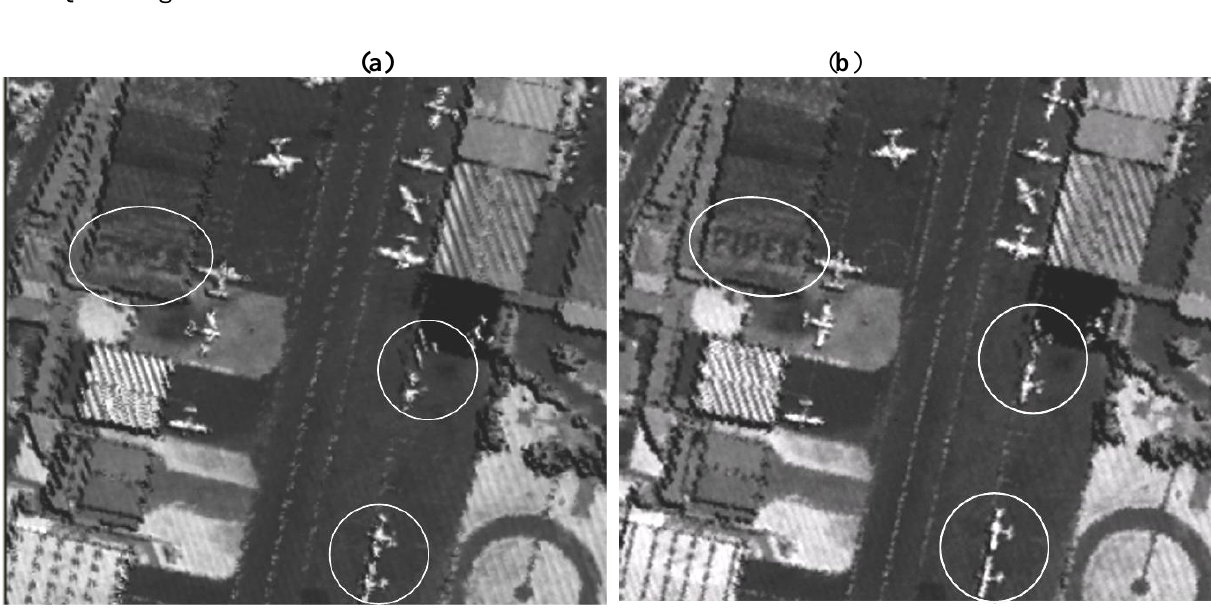
Figure 6. (a) Intensity image generated before the calibration procedure. (b) Intensity image generated after the calibration procedure using the Simplified method and test scenario III. (c) Intensity image generated after the calibration procedure using the Quasi-rigorous method and test scenario